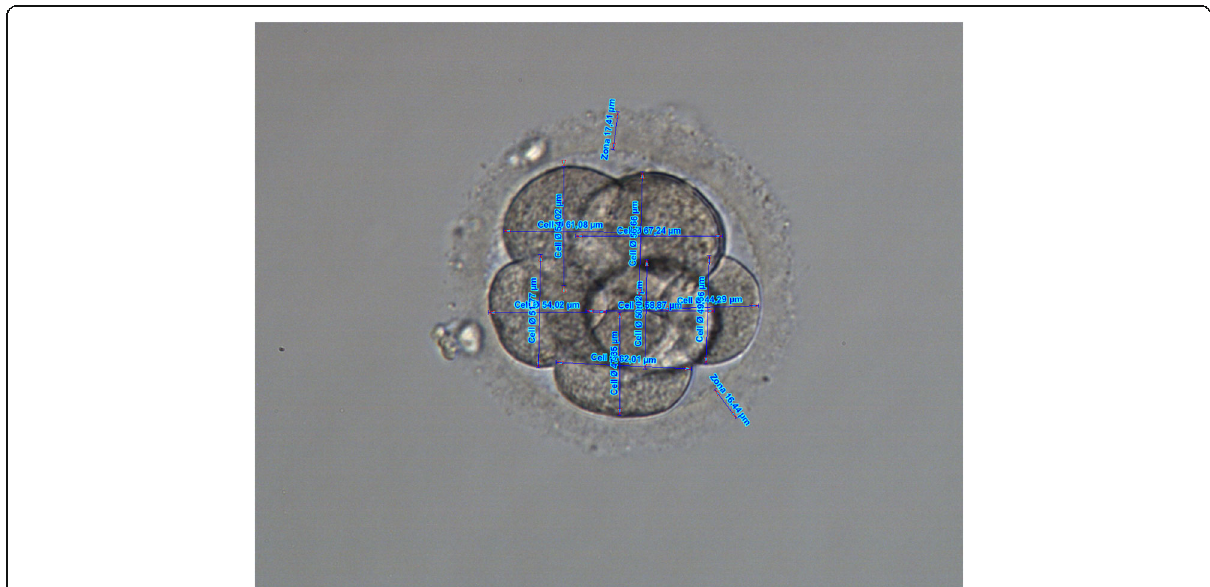
Fig. 1 Photograph of day 3 embryo showing the measurement of zona thickness in the embryo and mean blastomere diameter in each blastomere